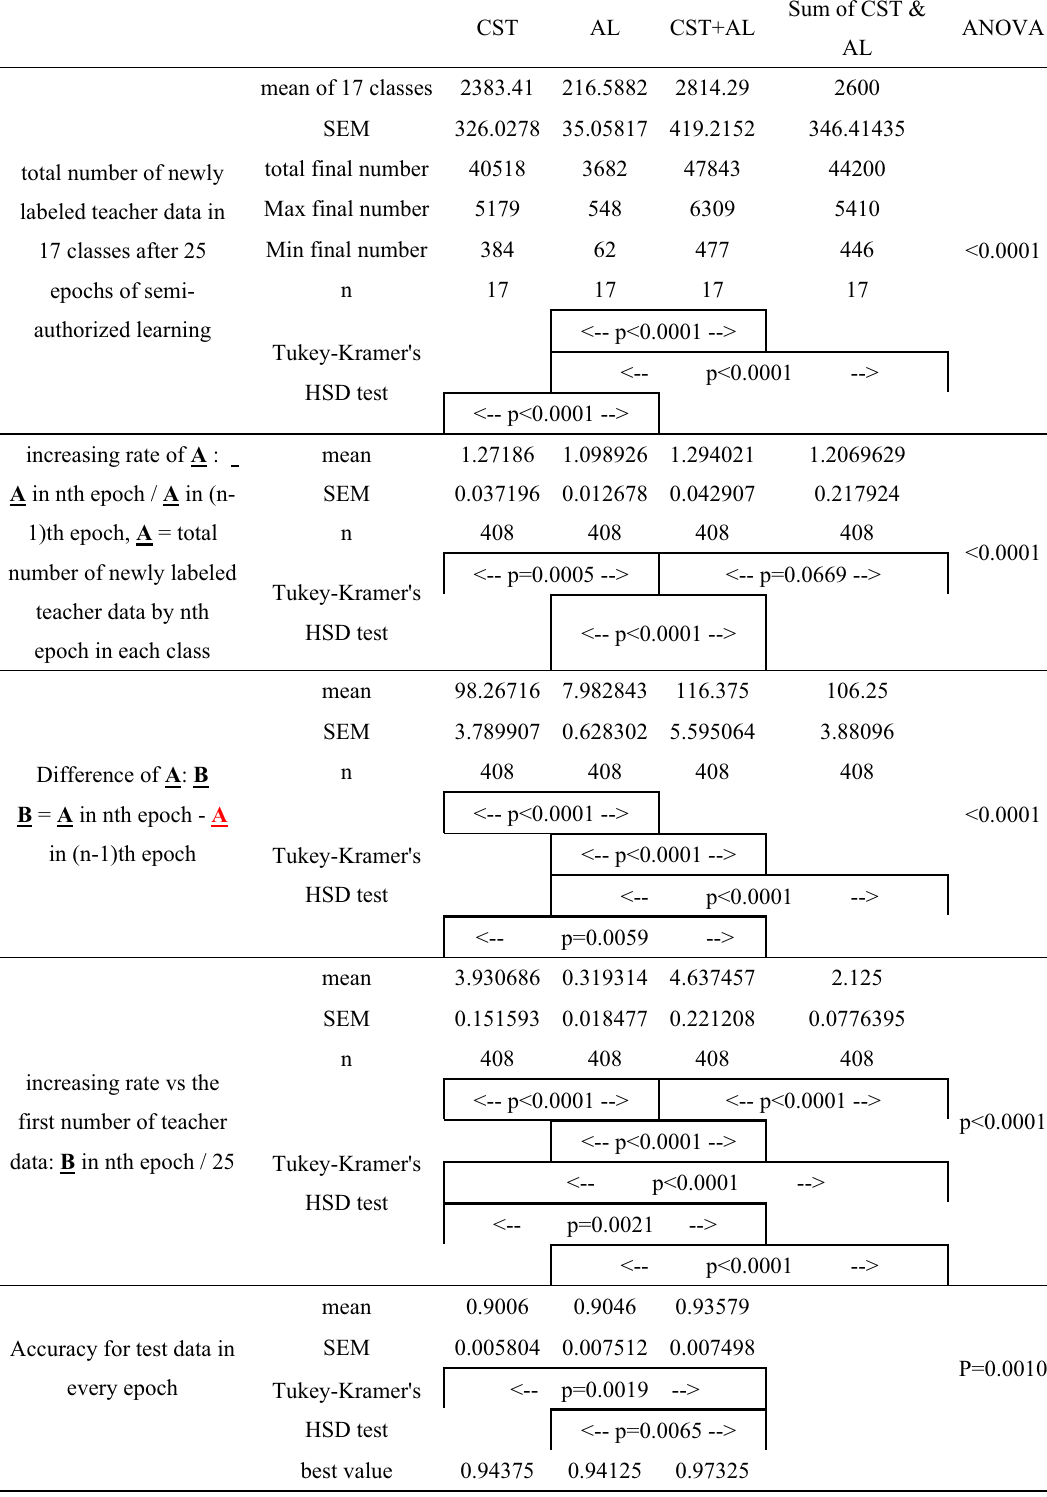
Table 2. Increasing number and rate of teacher data by class and